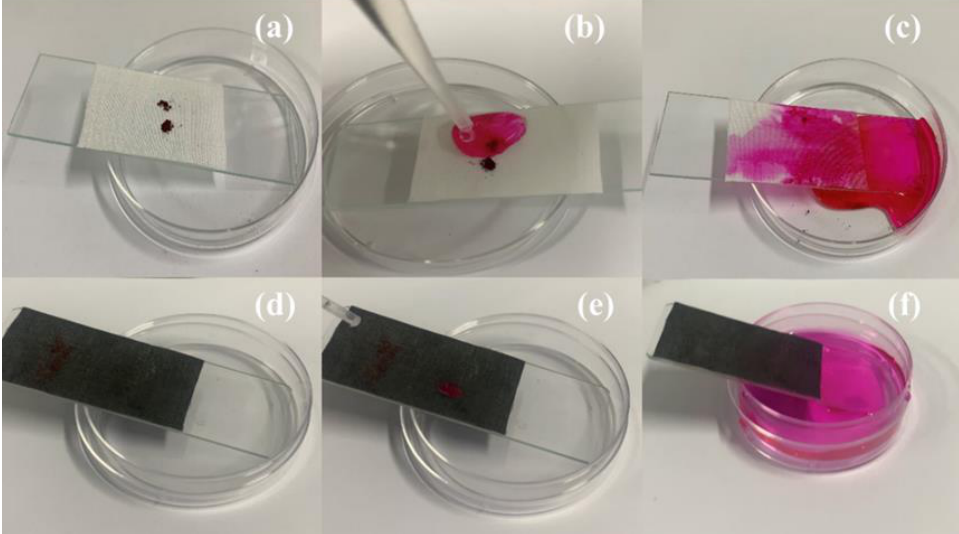
Figure 8. Self-cleaning performance of ( a – c ) original PET, ( d – f ) CA-Fe-SH-PET.